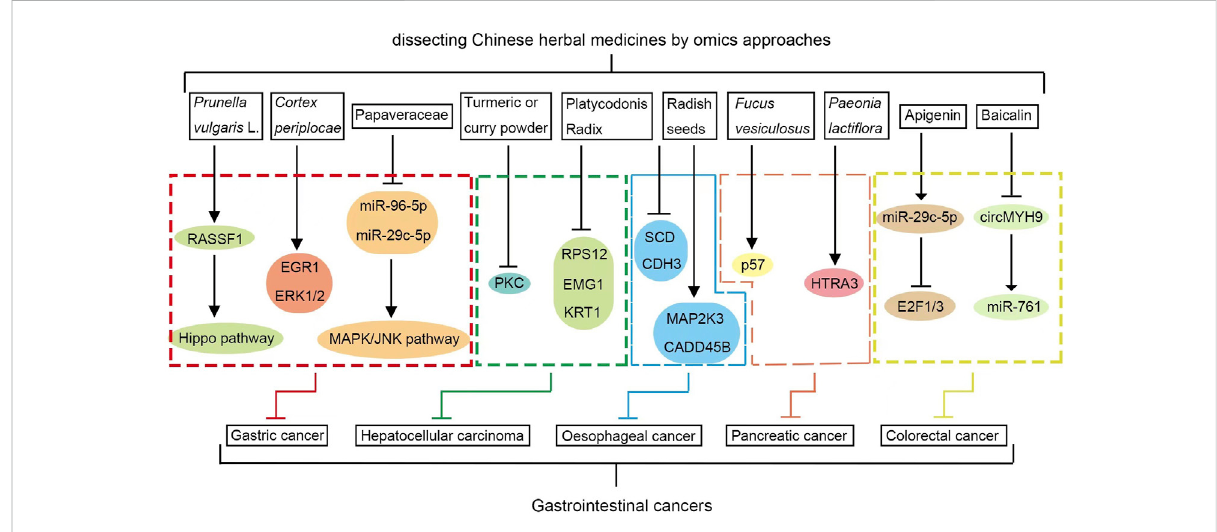
FIGURE 2 Underlying molecular mechanisms of Chinese herbal medicines in GI cancer treatment revealed by omics